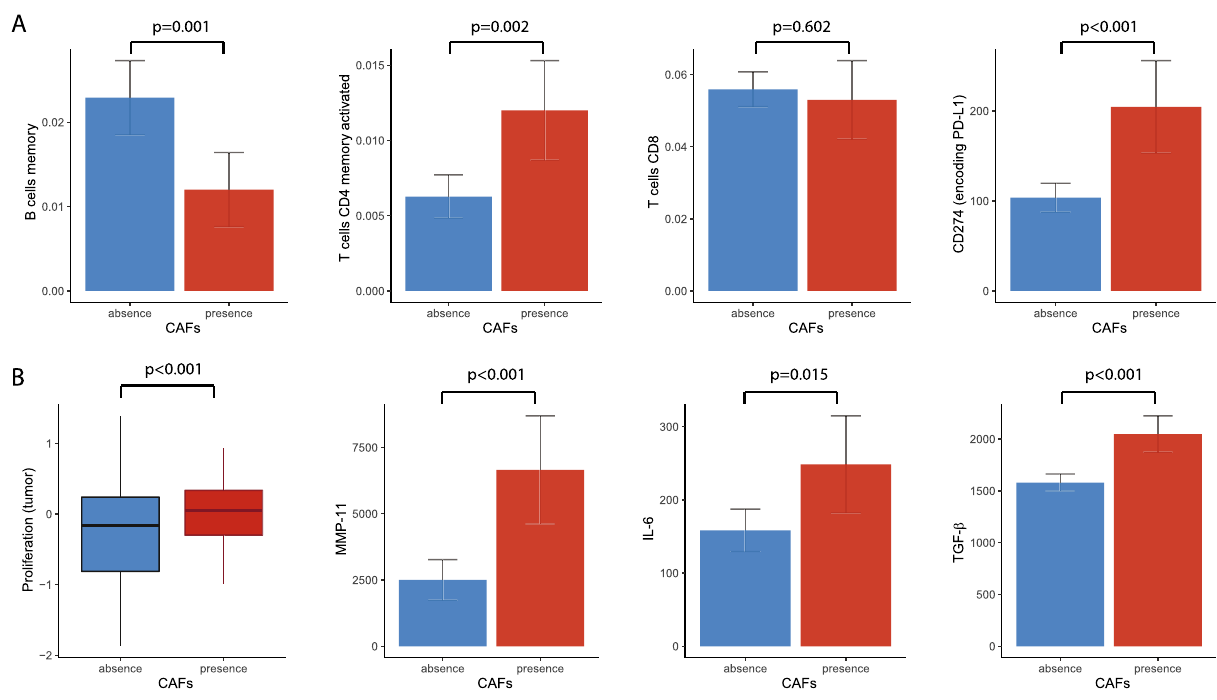
Figure 3. Bar plots of the relationships between cancer-associated fibroblasts and immune factors. ( A ) Memory B cells, activated CD4 + memory T cells, CD8 T cells and CD274 (encoding PD-L1) + cells ( p = 0.001, 0.002, 0.602 and < 0.001, respectively). ( B ) Relationships between tumor proliferation, matrix metalloproteinase-11 (MMP-11), interleukin-6 (IL-6) and transforming growth factor-β (TGF-β) ( p < 0.001, 0.001, = 0.015 and < 0.001,